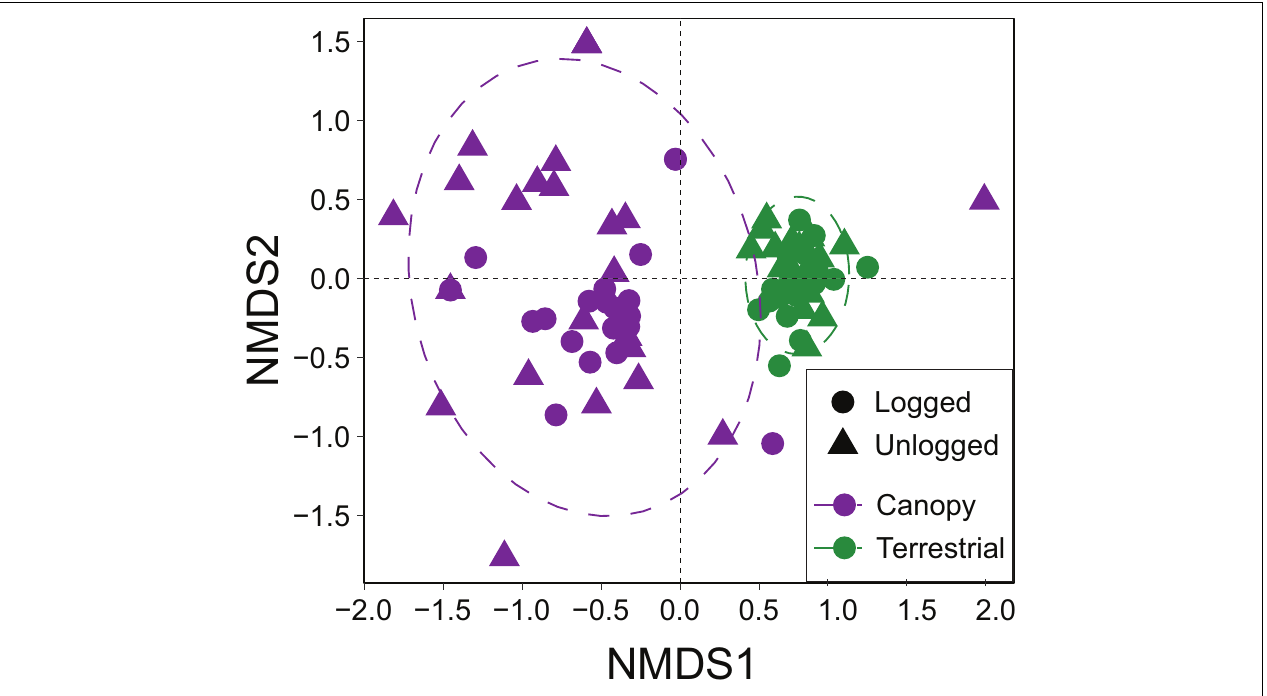
FIGURE 5 | Non-metric multidimensional scaling (NMDS) ordination showing variation in mammal community structure detected by camera-traps set in the canopy versus terrestrial strata of unlogged and logged